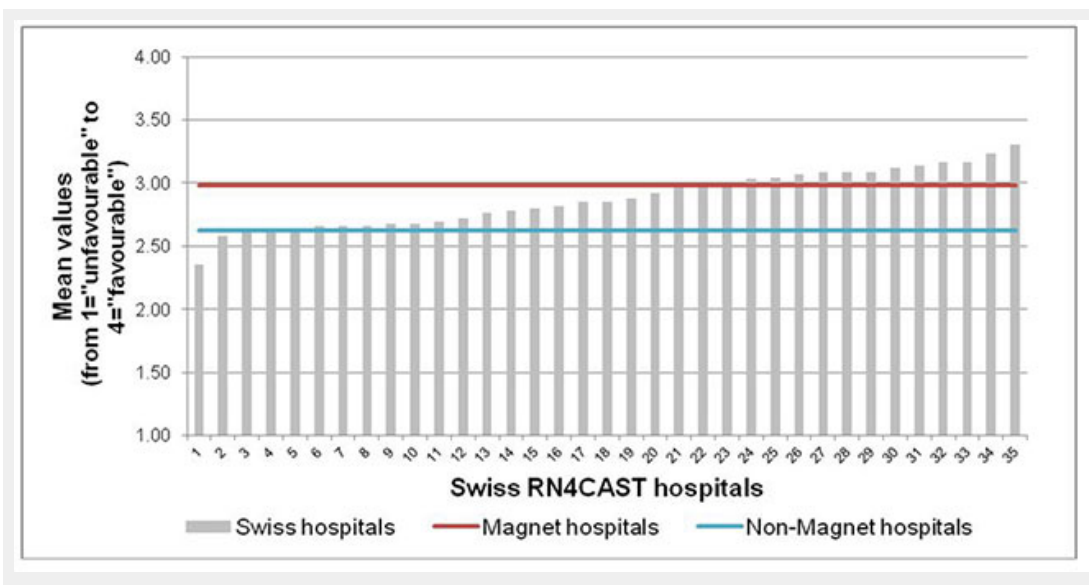
Figure 3 Variability in the quality of the nurse work environment (PES-NWI composite score) in our sample, compared to international data from Magnet and Non-Magnet